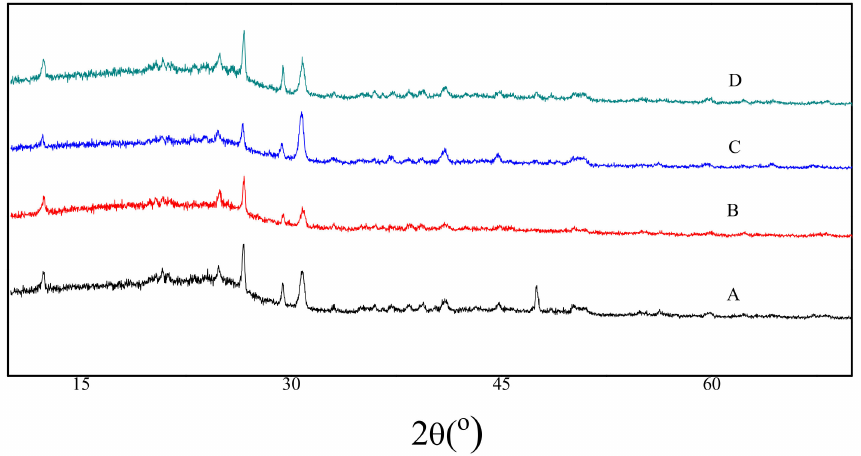
Figure 2. XRD spectra for the raw coal and the residues after extractions. ( A ) Raw coal. ( B ) The residues from the UAE. ( C ) The residues from SE. ( D ) The residues from the MAE.